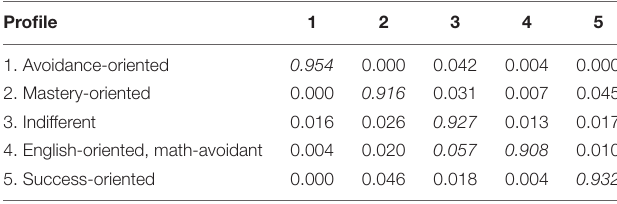
TABLE 3 | Average latent profile probabilities for most likely profile membership (row) by latent profile (column). Profile